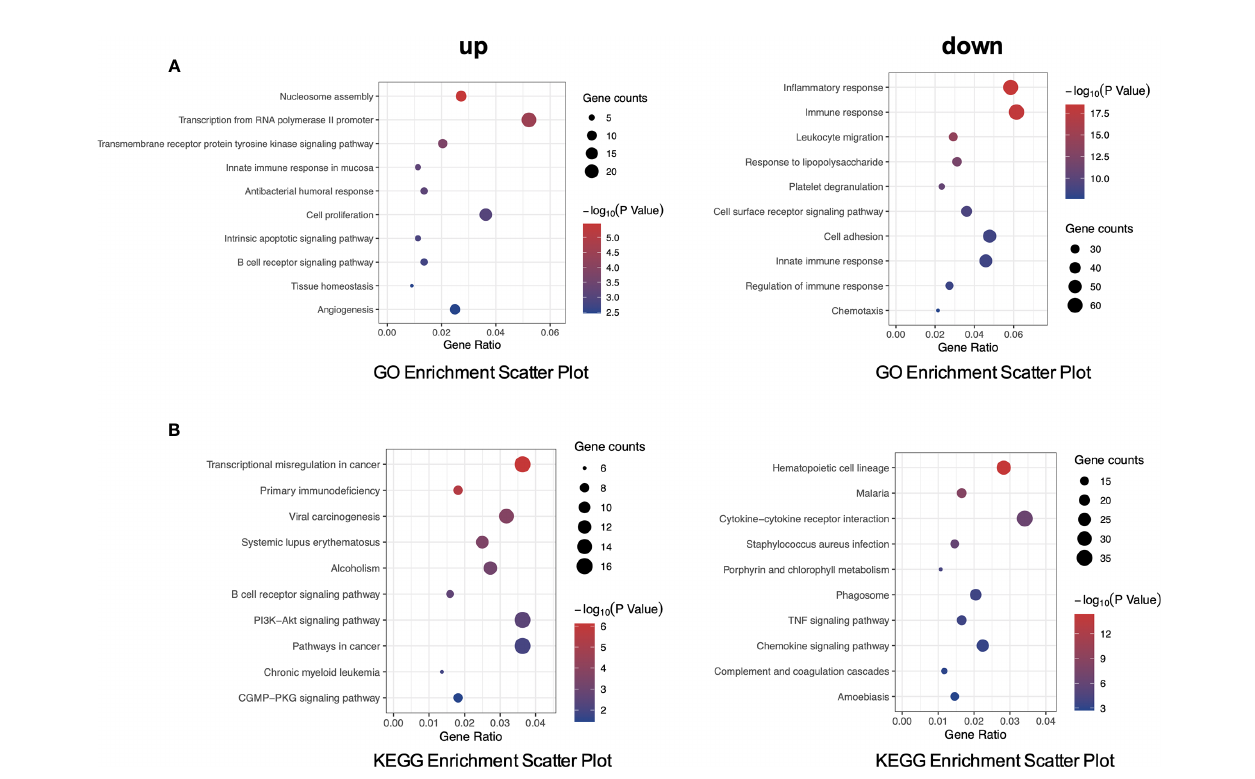
FIGURE 2 | PPI network by STRING. (A) GO enrichment analysis of up- and downregulated DEGs. (B) KEGG pathway analysis of up- and downregulated